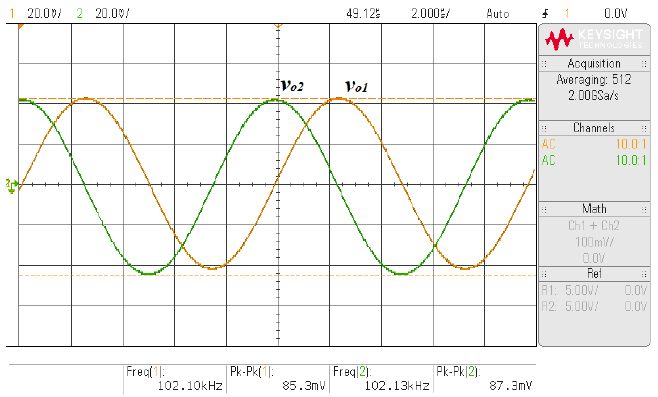
Figure 25. Measured quadrature waveform.